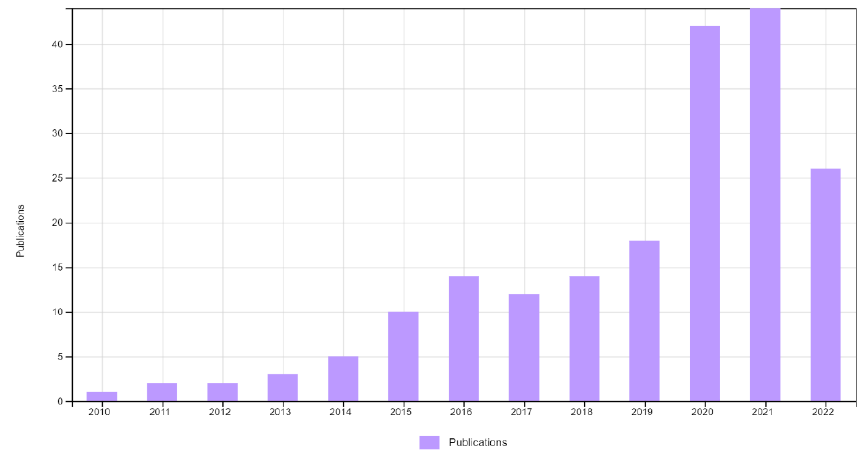
Figure 1. Scientific publications registered in WoS as of 22 September 2022, using as search descriptors [(Pedagogical Models AND Physical Education)] OR [(Pedagogical Model AND Physical Education)].